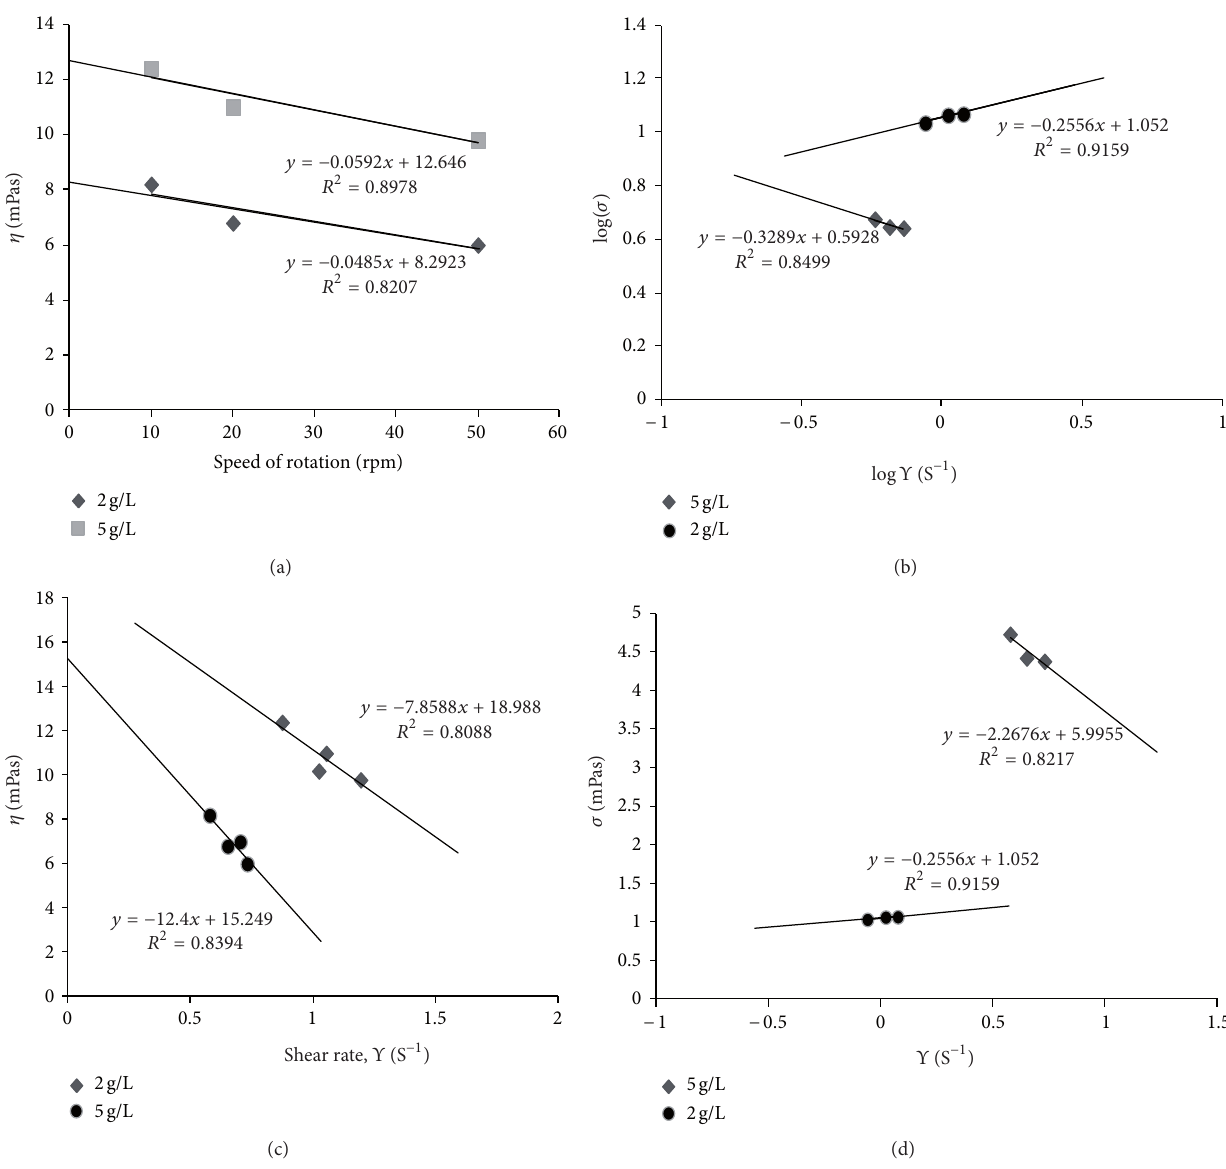
F 6: Variation of (a) viscosity with speed of rotation (b) log(shear stress), with log(shear rate), (c) viscosity with shear rate and (d) shear stress with shear rate for FP